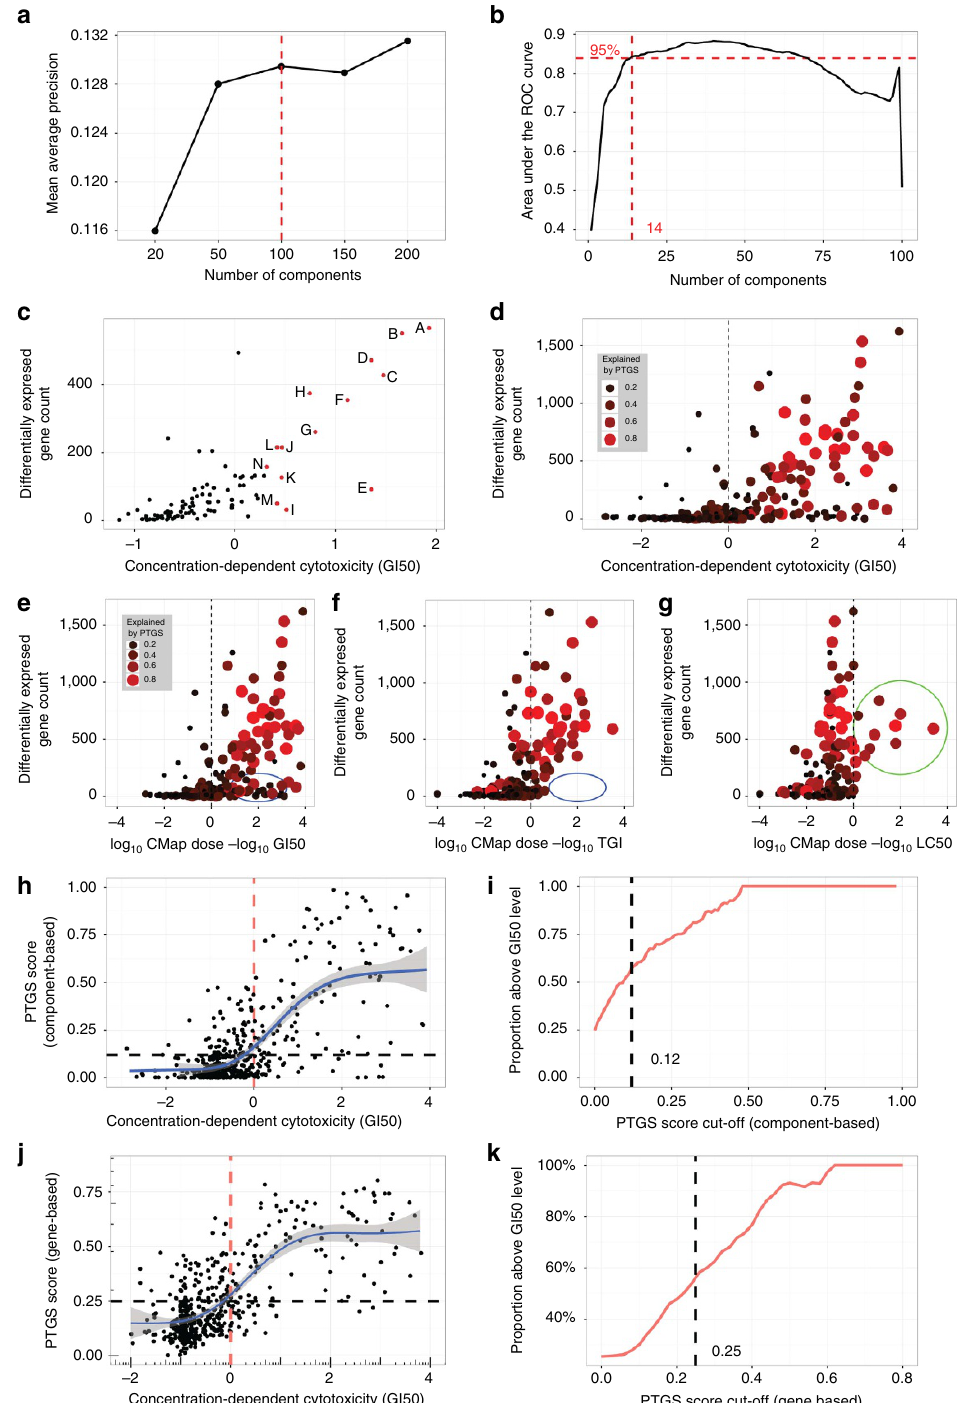
Figure 2 | Generating the PTGS and establishing the cytotoxicity-scoring concept. ( a ) Selecting the number of probabilistic components to retrieve as many biologically significant associations with as few components as possible. ( b ) Selecting an optimal size of the PTGS based on cytotoxicity-predictive performance relative to the NCI-60 data. ( c ) The 14 PTGS components (labelled) ranked based on their probability-weighted mean concentration- dependent cytotoxicity values (that is, log 10 CMap–log 10 GI 50 concentration) versus the number of associated genes. ( d ) Correlation of the number of differentially expressed genes with the concentration-dependent cytotoxicity. Colour and size indicate amount of transcriptional variation explained by the PTGS that is, the component-based score ( n ¼ 492). ( e , f ) Instances with a small number of differentially expressed genes tend to have cytotoxicity below the TGI level (blue oval), whereas ( g ) compounds profiled at cell-killing doses ( 4 LC 50 ) show greater differences (green circle). ( h ) Analysis of component- based PTGS scores versus concentration-dependent cytotoxicity was used to determine ( i ) a cut-off, plotted here against the proportion of instances above the GI 50 -level. Dashed red line indicates the threshold at the GI 50 -level and the dashed black line the cut-off at 0.12 when B 50% of CMap instances are above GI 50 . ( j ) The gene-based scoring, based on the proportion of active PTGS-related genes, was evaluated similarly. ( k ) The cut-off was set at 25% (cf. Supplementary Figs 4 and 5, for data see Supplementary Data